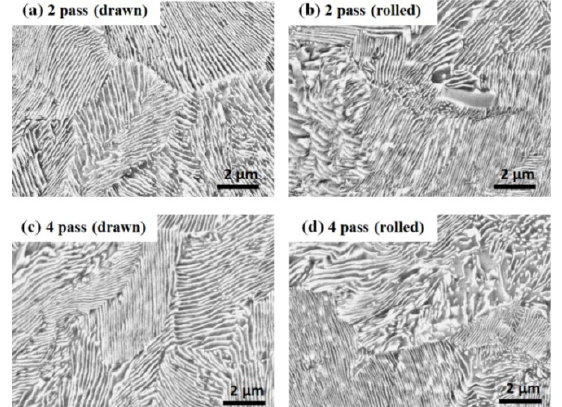
Figure 7. Comparison of the microstructures of the drawn and caliber-rolled pearlitic steel wires with strain. Quarter region was measured.